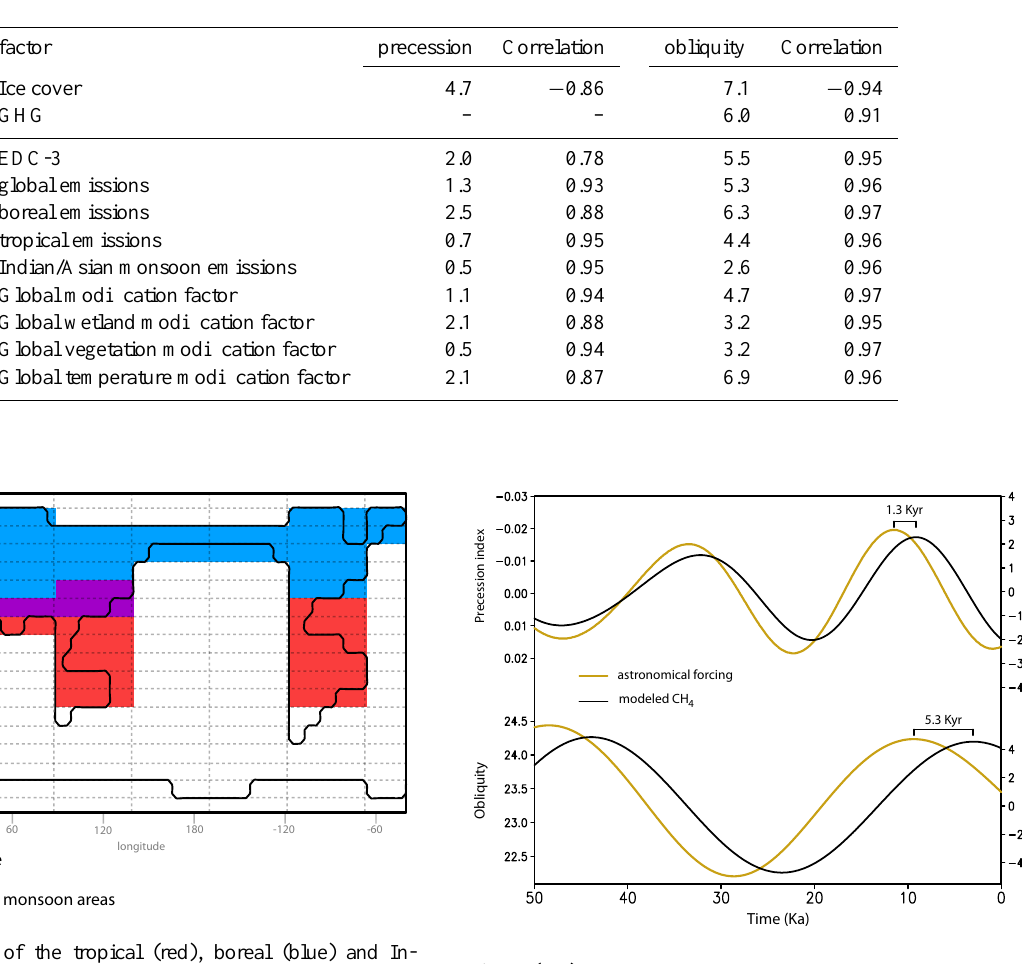
Table 1. Lags with respect to the orbital forcing in ice cover, greenhouse gases and EDC-3 atmospheric CH 4 , in the TRENCH simulated global and regional emissions and in the global modification factors. Lags are computed by searching for the optimum correlation between the forcing (precession or obliquity) and a given variable, band pass filtered at 21Kyr or 41Kyr, respectively. Zero phase is set at minimum precession and maximum obliquity, which each correspond to an insolation maximum for the NH. The correlation value is displayed next to the lag.